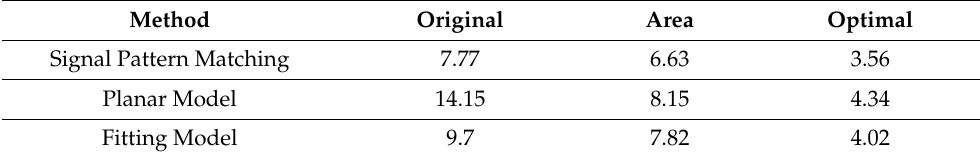
Table 8. Comparison of Average Positioning Error on the Basketball Court.